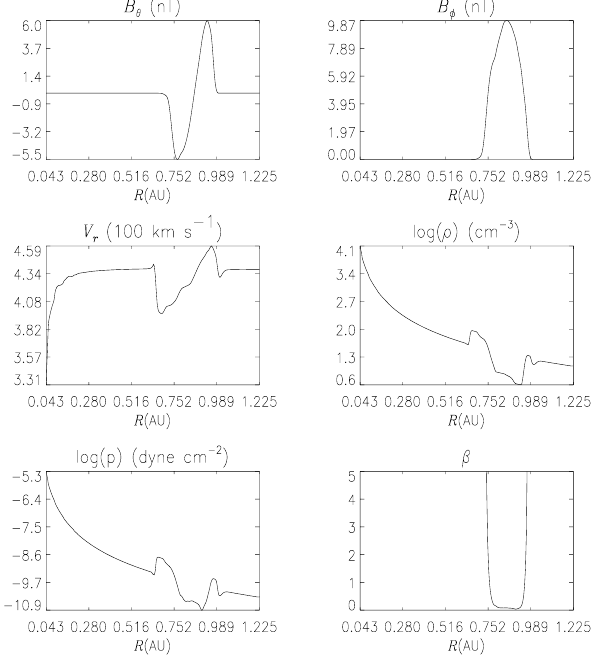
Fig. 5. As Fig. 2, except that the initial ICME speed is now 0.5 times that of the solar wind. The results are shown 3.29 days after onset.